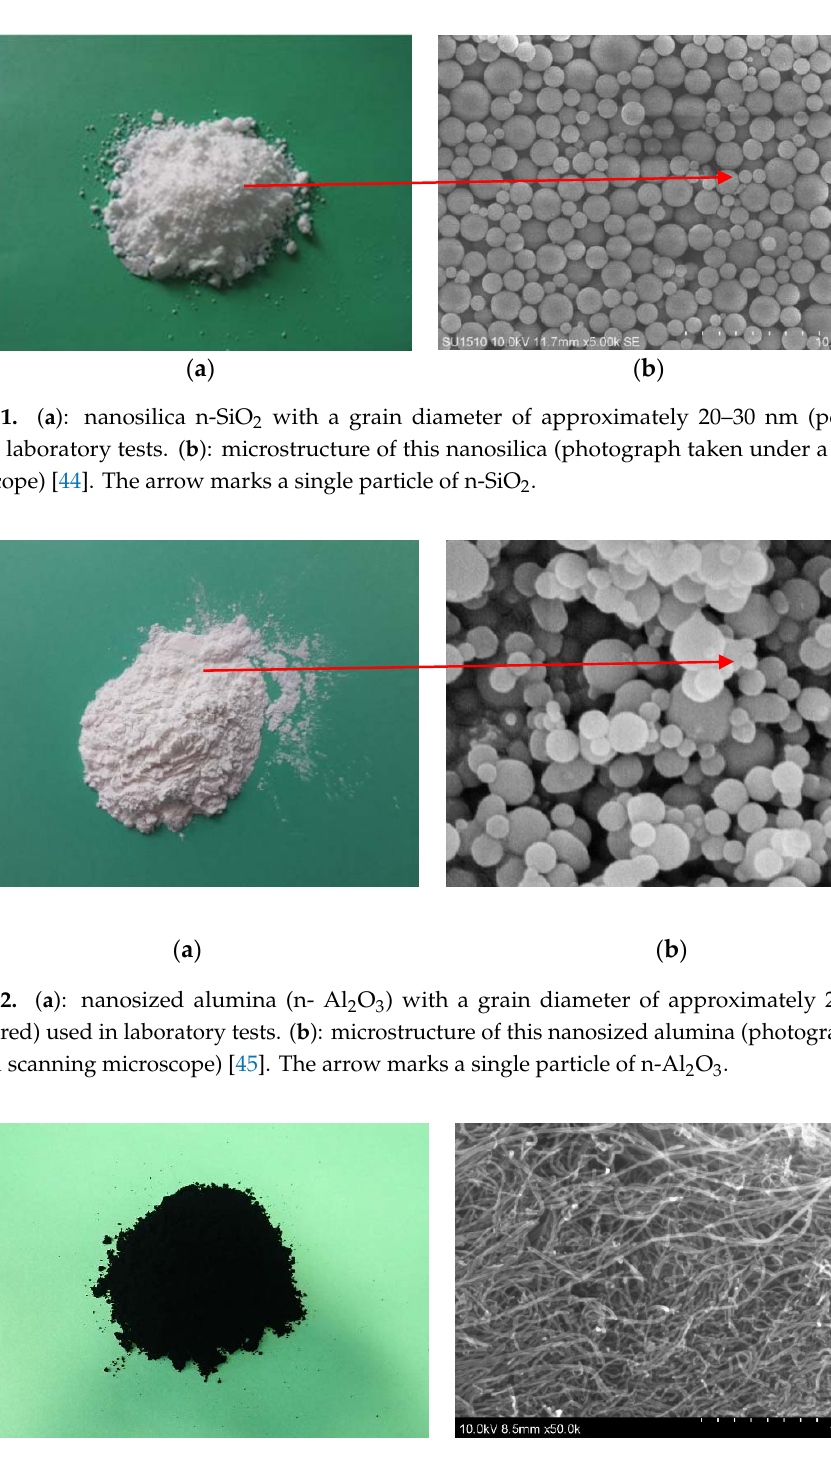
Figure 3. ( a ): multi ‐ walled carbon nanotubes (MWCNTs) with an external diameter of approximately 10–20 nm and length of 10–30 μ m (in the form of black powder) used in laboratory tests. ( b ): microstructure of carbon nanotubes (picture taken under a transmission electron microscope) [46].